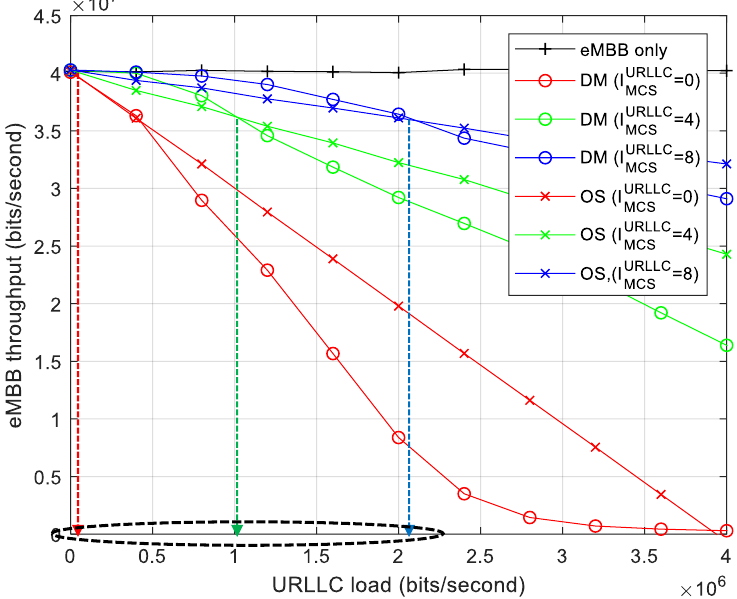
Figure 4. Capacity region with varying the URLLC MCS index: DM vs.